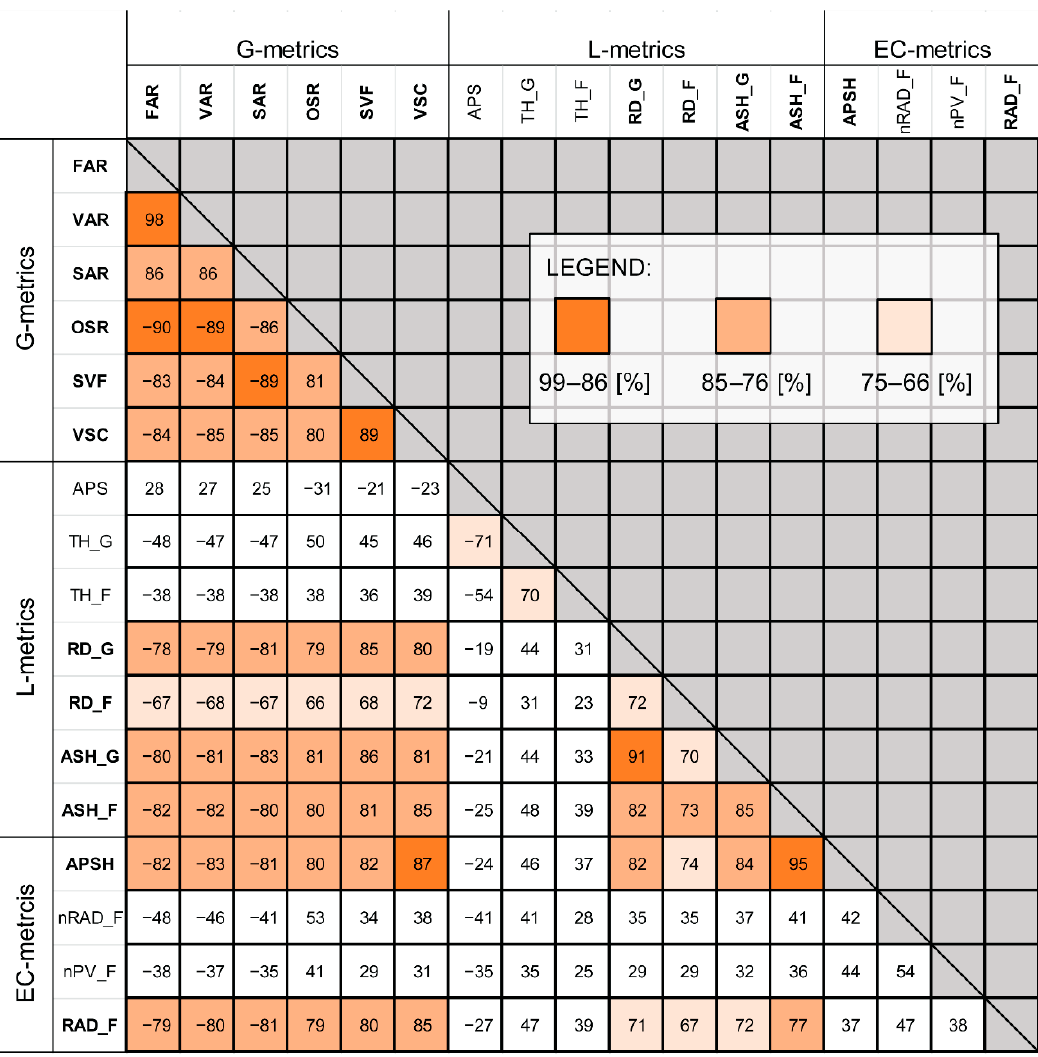
Figure 9. Correlation (Kendall) of metrics from iteration-based datasets simulated for Frankfurt and Stockholm presented in percentage format. τ B values equal to 100% indicate perfect agreement. Metrics were described in Table 2.